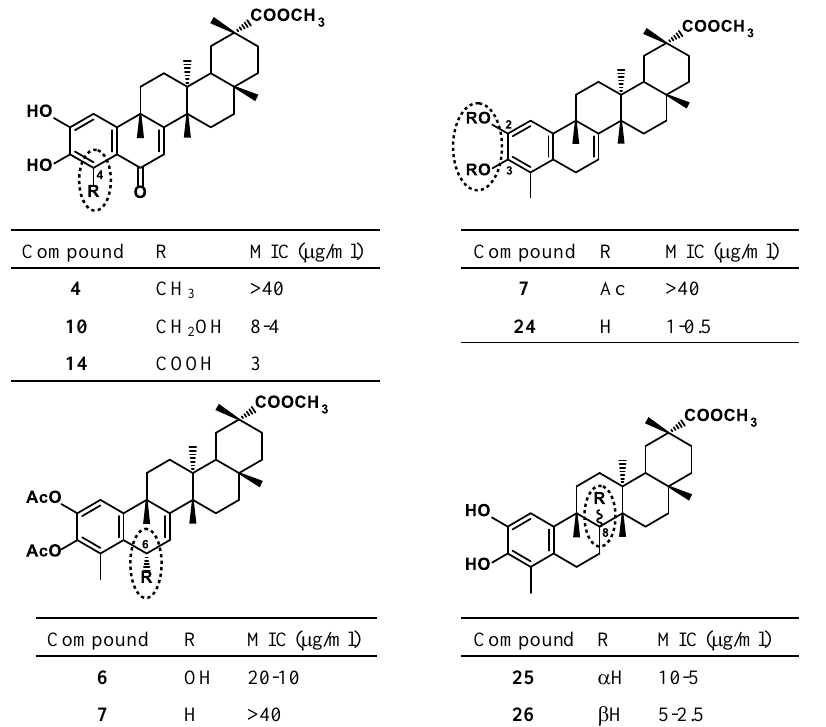
Figure 4. Most relevant structural features for phenolic nor-triterpenes against the most sensitive microorganism, Bacillus subtilis